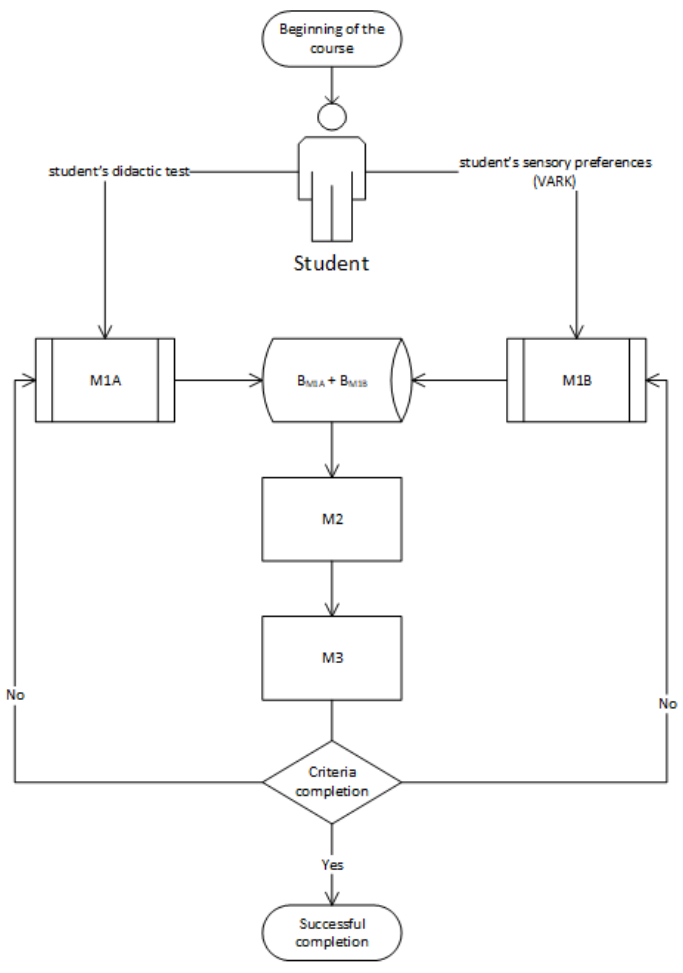
Figure 1. Representation of modules to create student’s study plan.